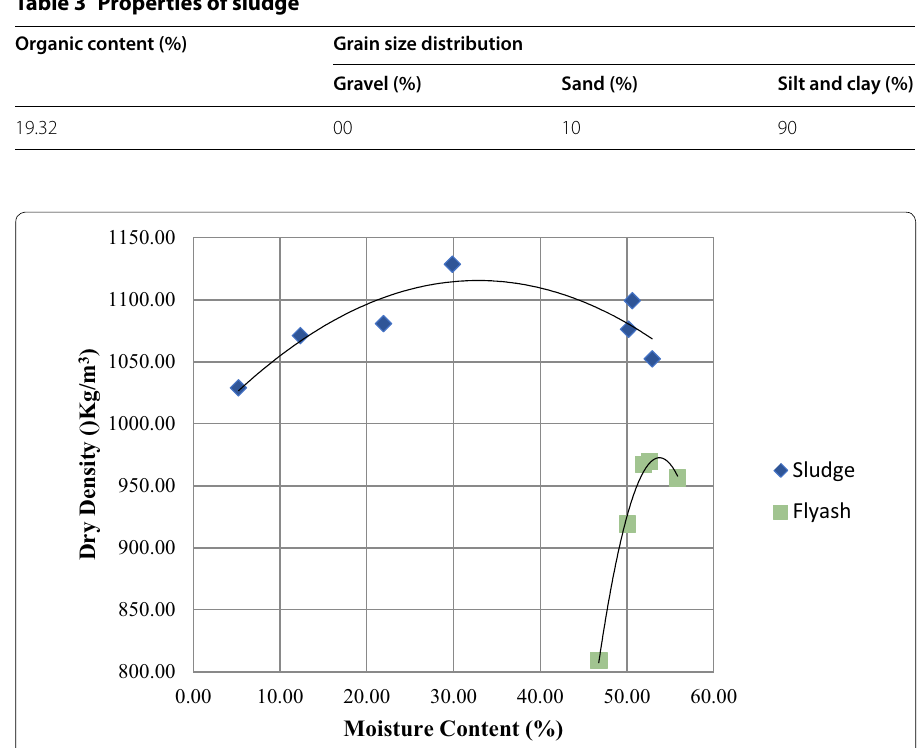
Fig. 2 Results of standard proctor test on unimproved sludge and